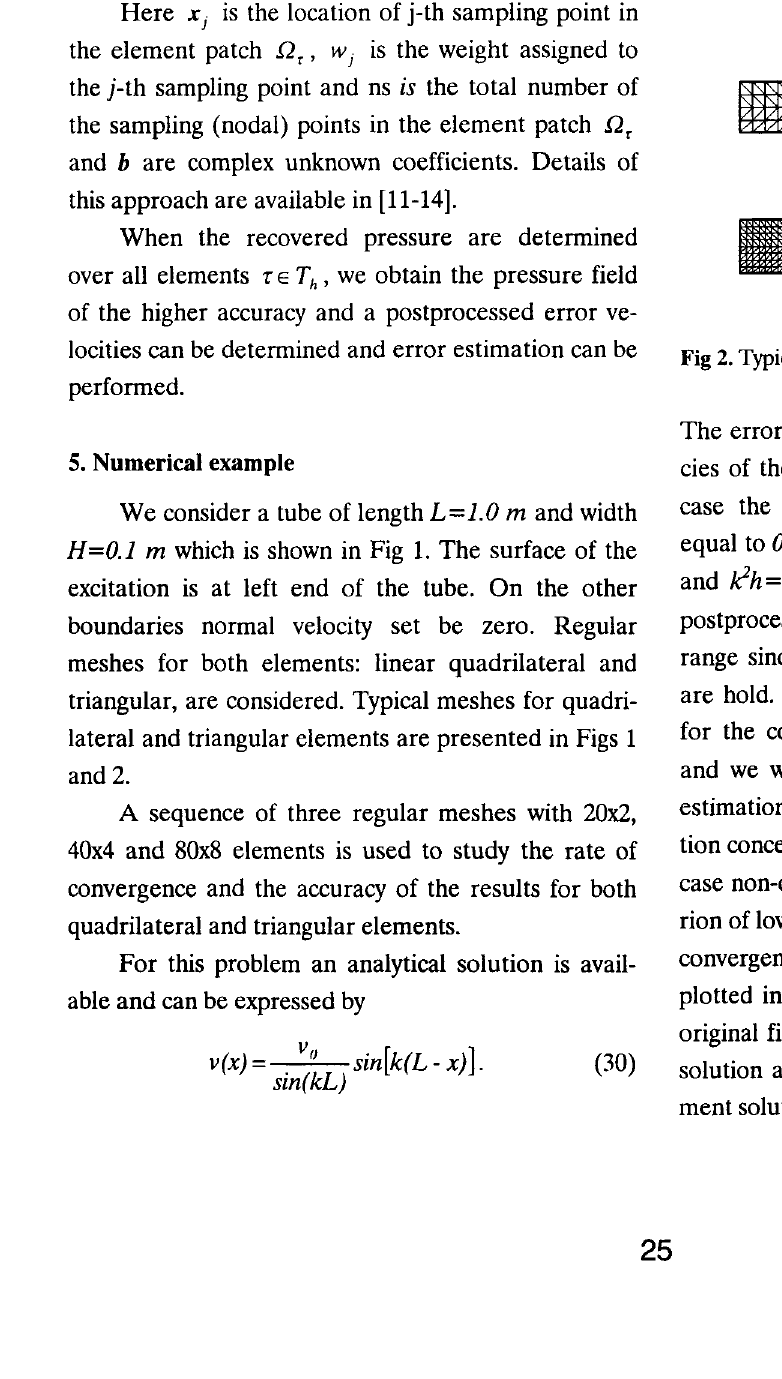
Fig 1. Geometry, excitation and typical quadrilateral meshes